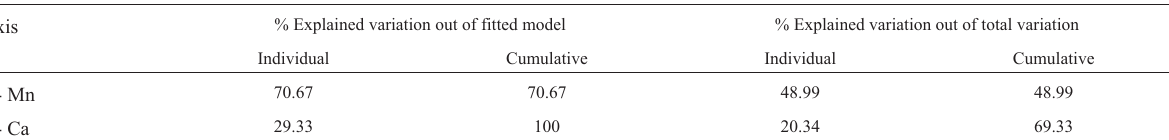
Table 7 - Distance-based linear model (DistLM) analysis of variables included in the most parsimonious model for the relationship between bacterial abundance and environmental